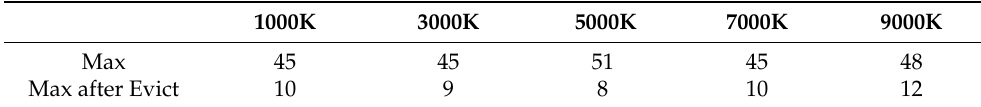
Table 1. PORAM stash size